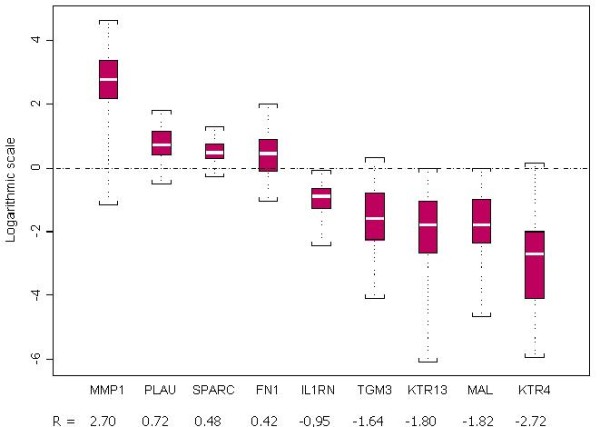
Differential mRNA expression of the nine genes of interest in macroscopically healthy mucosa and HNSCC tissue. For estimation of the individual expression of each gene, the expression ratios of paired tissue specimens were calculated as R = HNSCC/normal. The distribution of the log of these ratios is represented for each gene by a box-plot. The central box represents the interquartile interval, the white line inside the box is the median value, and the minimum and the maximum values are indicated with square brackets.